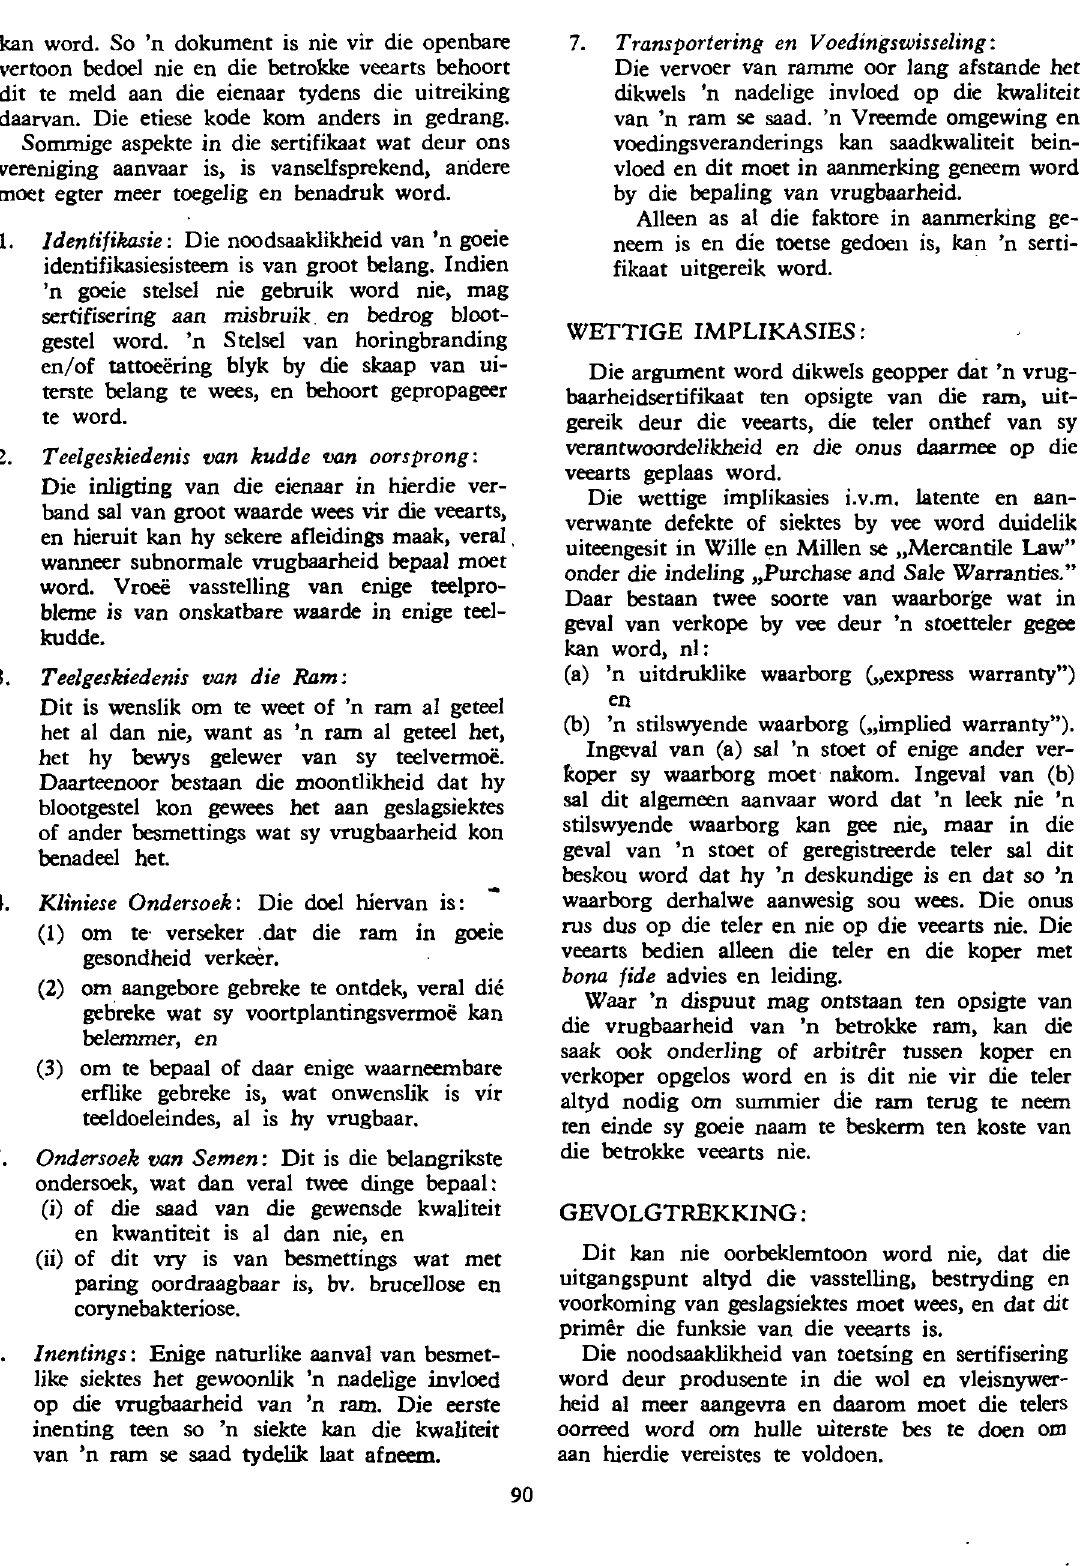
dit te meld aan die eienaar tydens die uitreiking daarvan. Die etiese kode kom anders in gedrang. Sommige aspekte in die sertifikaat wat deur ons vereniging aanvaar is, is vanselfsprekend, andere moet egter meer toege1ig en benadruk word. Identifikasie: Die noodsaaklikheid van 'n goeie identifikasiesisteem is van groot belang. Indien 'n goeie stelsel nie gebruik word nie,